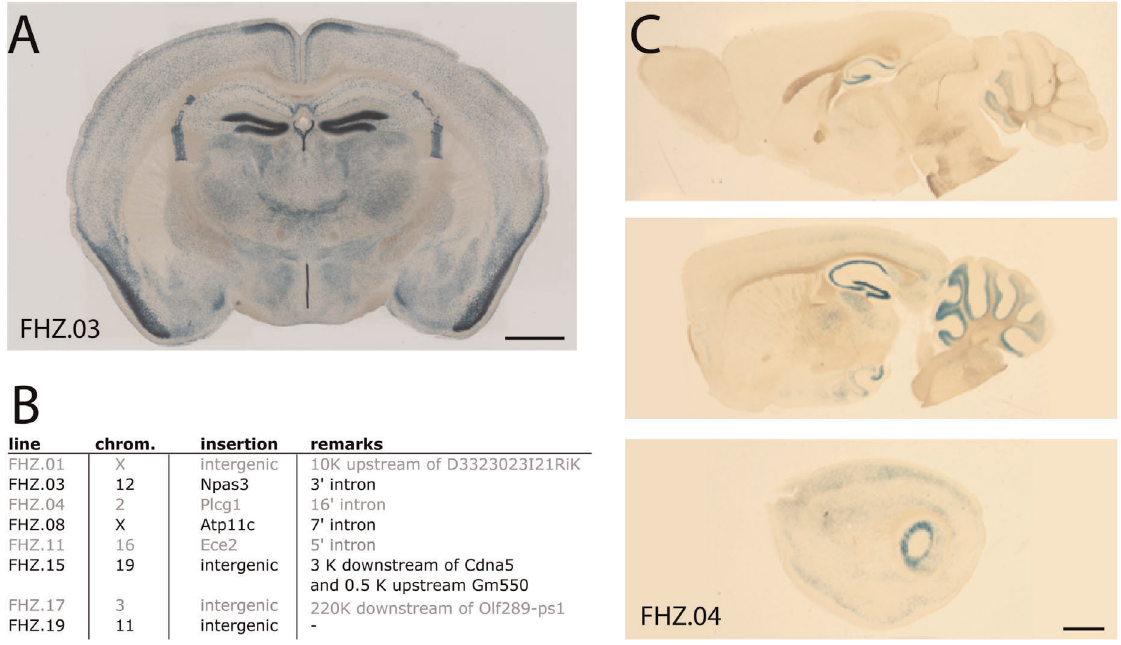
Figure 3. Labeling of subsets of neurons in different hsp68-nlacZ lines. (A) Coronal section of a mouse carrying a single copy of the hsp68- nlacZ transgene that integrated into the coding region of the Npas3 gene (bar=1 mm). (B) The table shows the genomic insertion site of eight mouse lines carrying a single copy of the hsp68-nlacZ transgene. (C) Sagittal sections of a mouse carrying a single copy of the hsp68-nlacZ transgene that integrated into the coding region of the Phospholipase C-gamma1 gene. Medial to lateral sections of the brain reveal a medio-lateral expression gradient both in the hippocampus and cerebellum (bar=1mm).